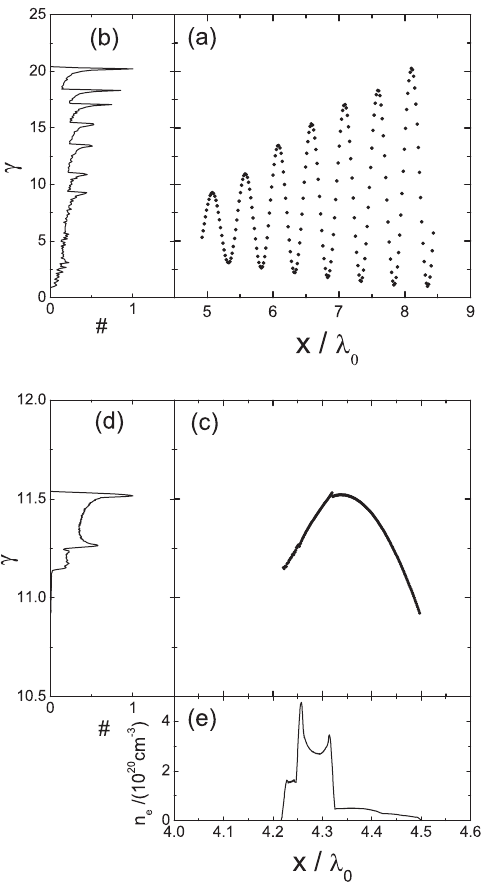
FIG. 3. Electron sheet distribution in phase space at (cid:3) ¼ (cid:3) m for cases with unchirped (a) and chirped (c) pulses. (b), (d) and (e) are the corresponding energy spectra and density distributions of (a) and (c). The coordinate ‘‘#’’ is the normalized counted number. The longitudinal coordinate of (e) is labeled as electron density.